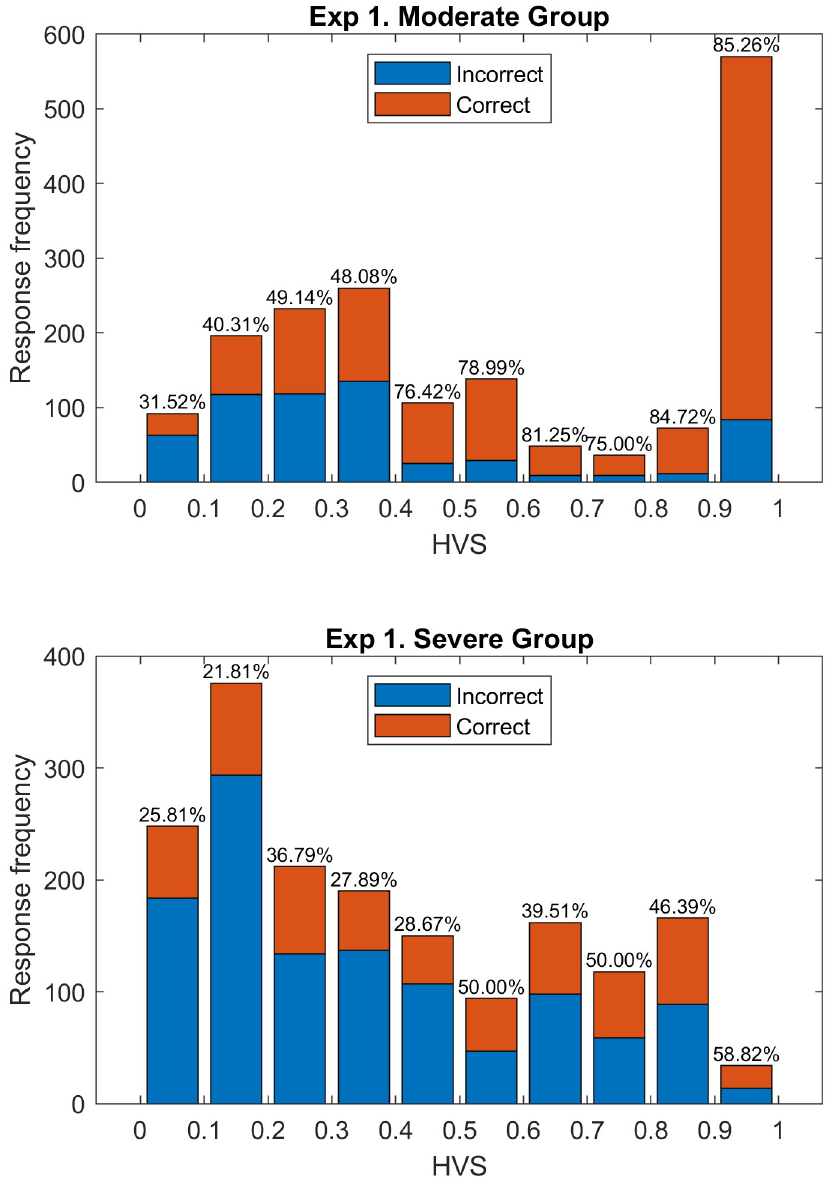
Fig 5. Histograms presenting correct and incorrect trials in each 0.1-wide bin of the HVS accumulated across seven subjects in each blur group. The upper panel shows the distribution for moderate blur group trials, and the lower panel shows the distribution of severe blur group